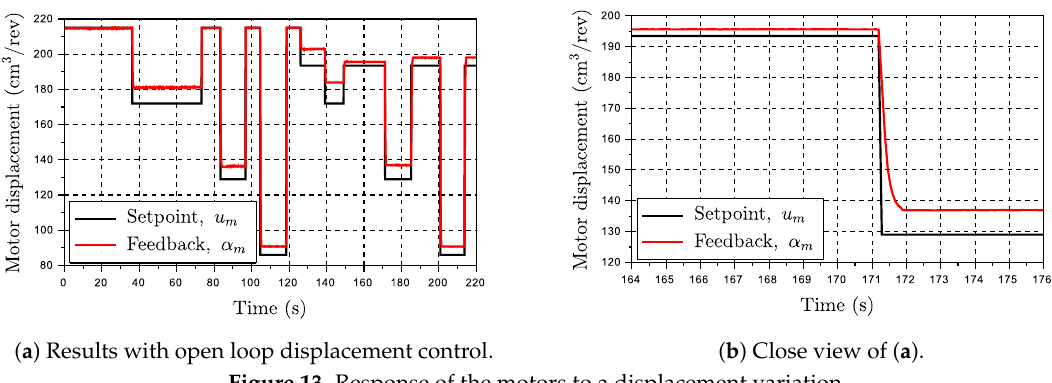
Figure 13. Response of the motors to a displacement